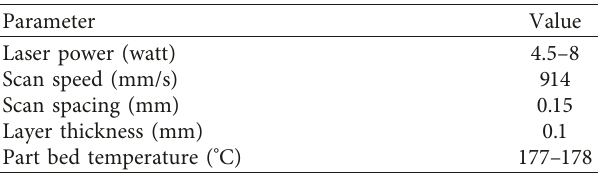
Table 3: Manufacturing conditions of PA12/white cement